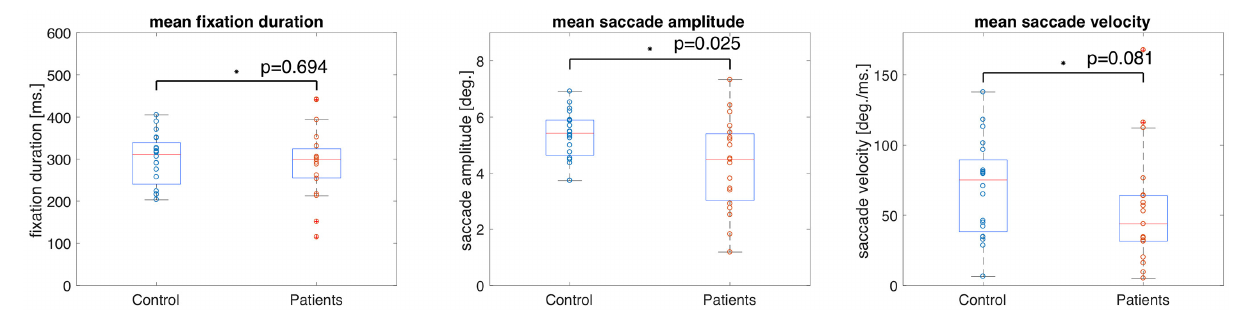
FIGURE 1 | Box and whisker plots showing the means and 25–75 percentiles of three different eye movement features of glaucoma patients and controls. Circles represent the results of individual participants. The glaucoma patients showed significantly lower saccade amplitudes than the control group.